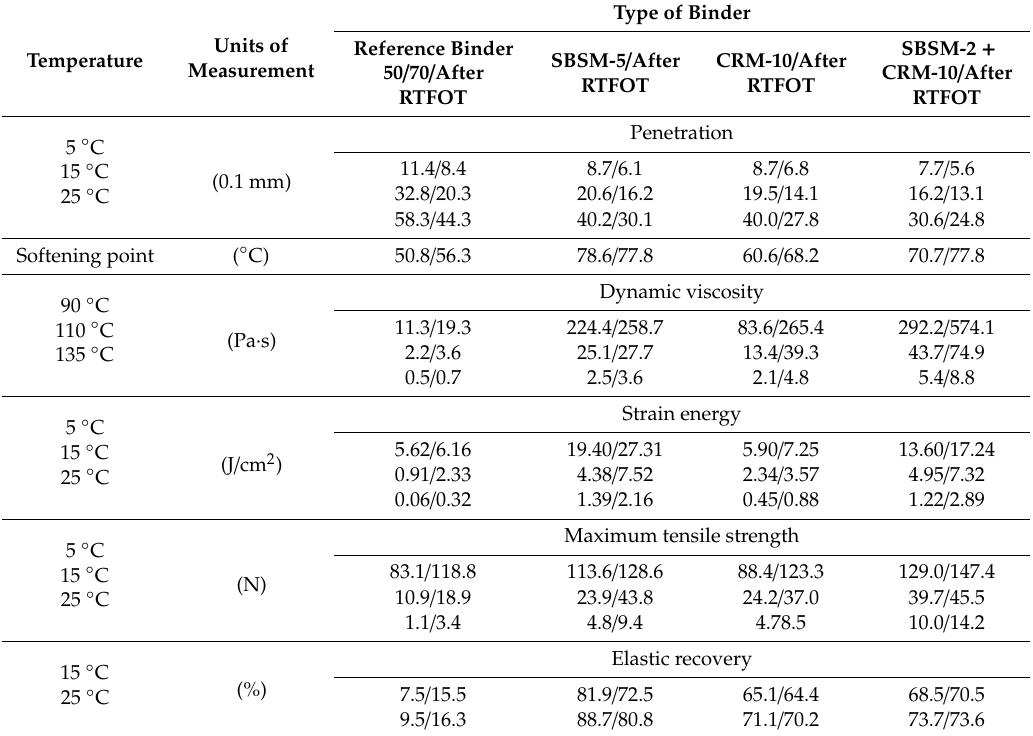
Table 1. The tested technical properties of modified binders.